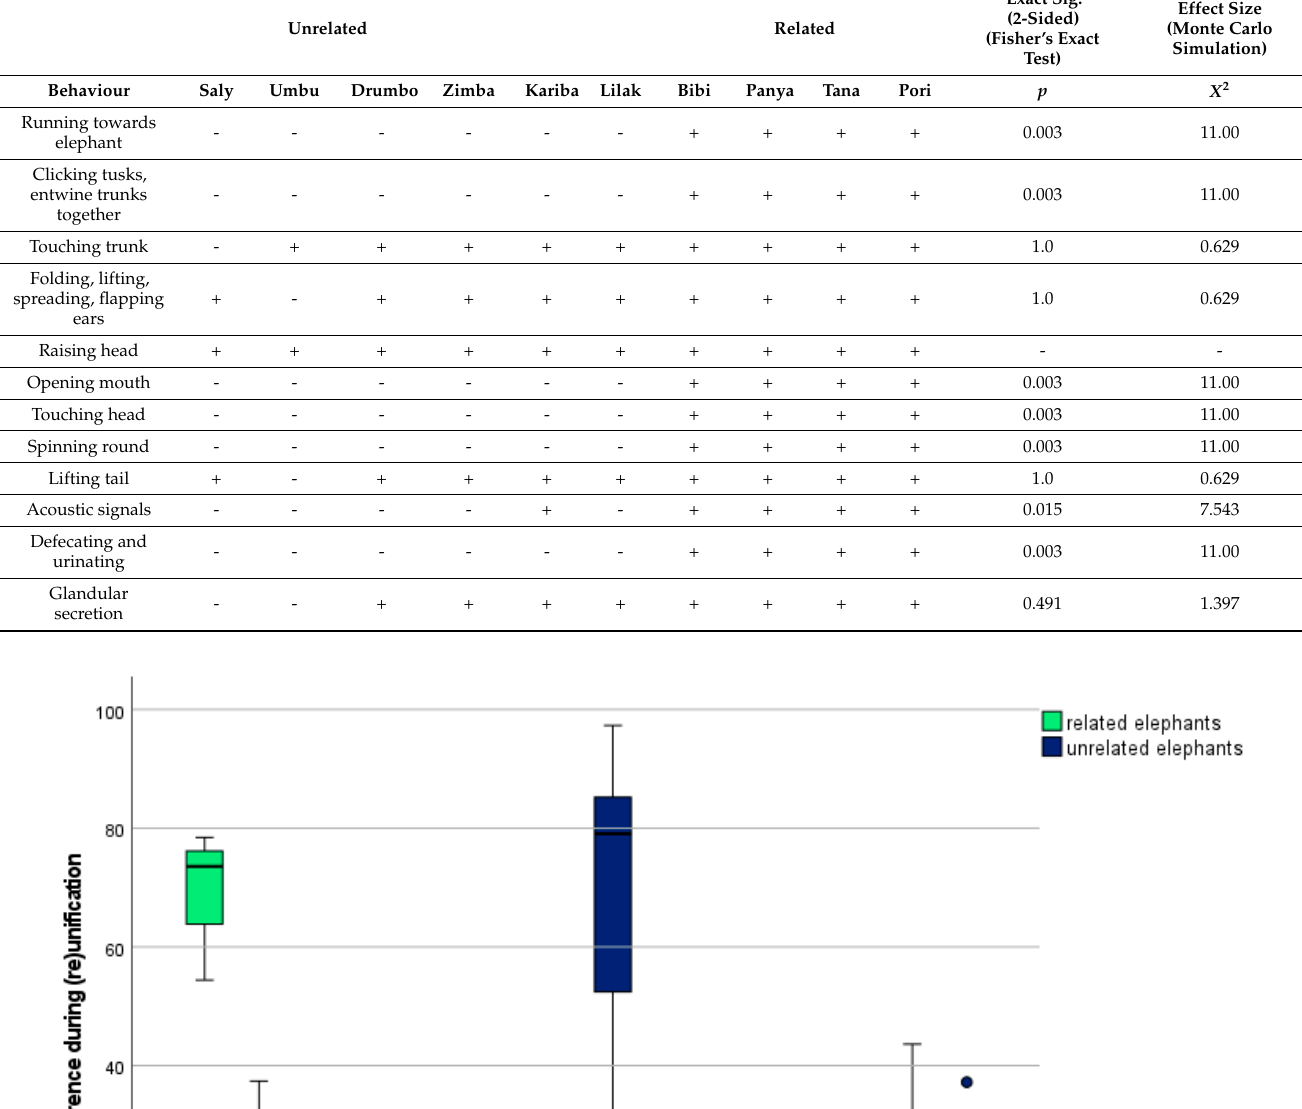
Table 4. Differences in expressed behaviour during (re)unifications.